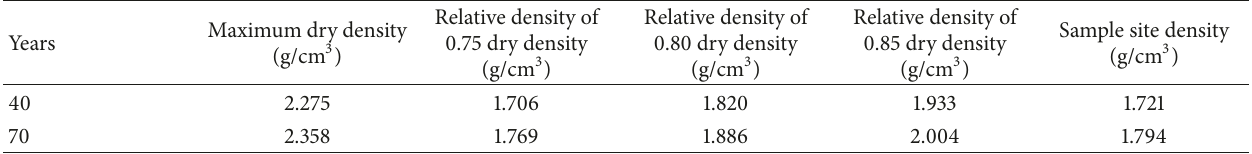
Table 1: Relative density test results (700 samples).